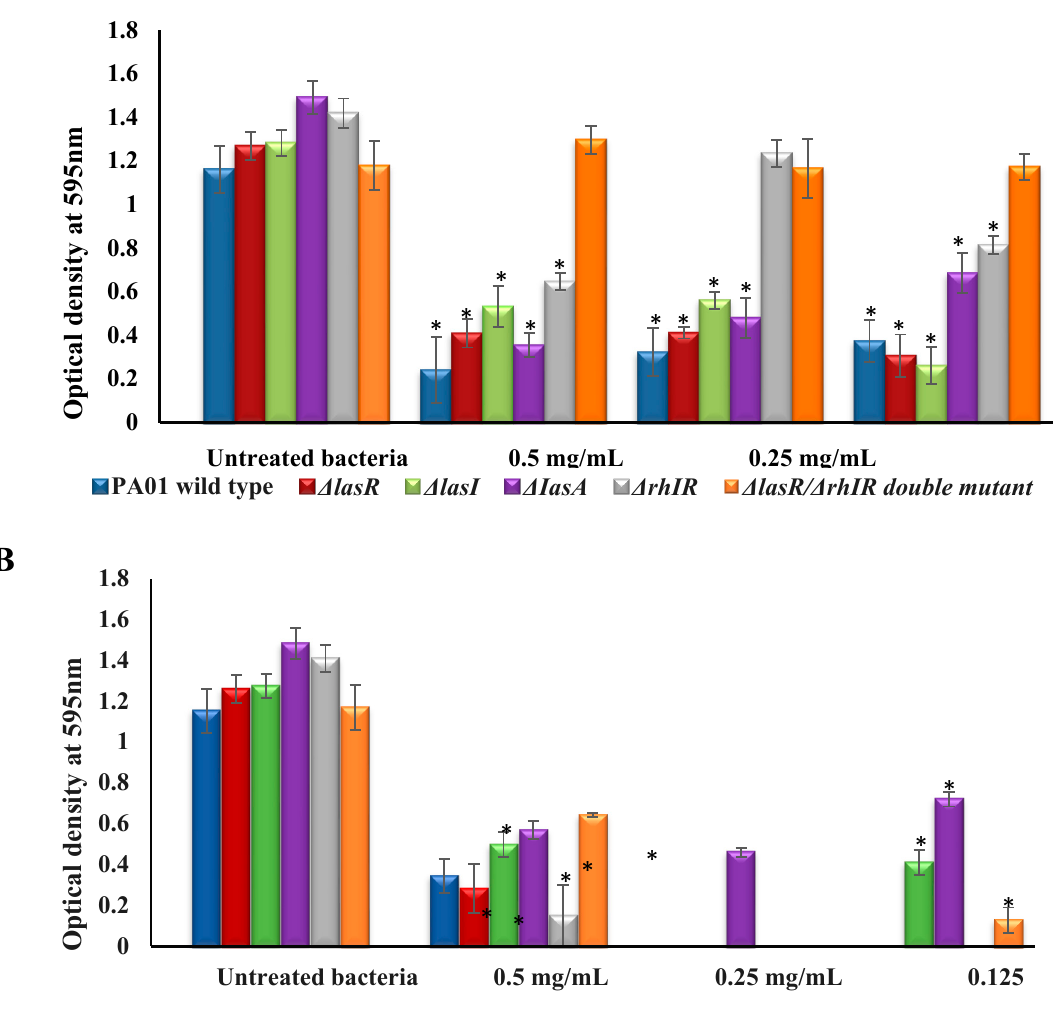
Figure 3. Biofilm quantification assay of P. aeruginosa strains. Quantifications of biofilm of PA01, ∆ lasR , ∆ lasI , ∆ IasA , ∆ rhIR , and ∆ lasR / ∆ rhIR double mutant were performed in the presence of 0.125–0.5 mg/mL of ( A ) mBTL or ( B ) mBTL-loaded CANPs by crystal violet assay. Experiment performed in triplicate (mean ± SD). Based on Student t test, (* p < 0.05) indicates significant reduction in biofilm